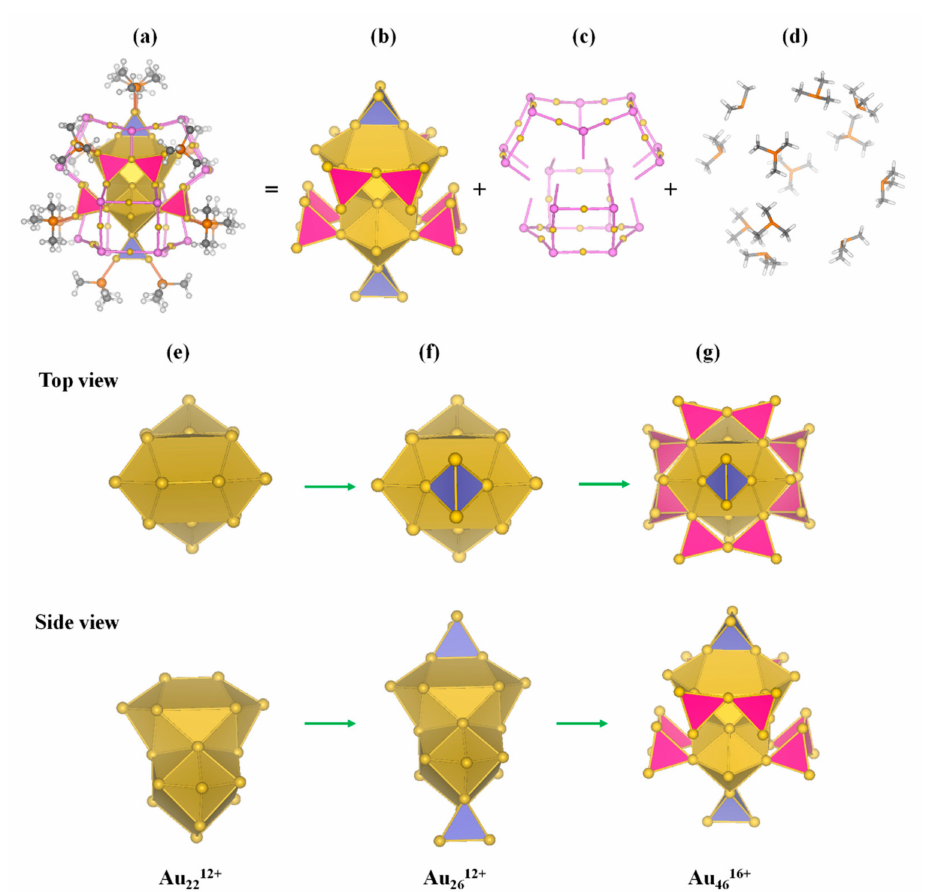
Figure 3. ( a ) Structural model of Au 70 S 20 (PCH 3 ) 12 . The [Au 12 ( µ 3 -S) 10 ] 8 − a nd PCH 3 protecting motifs are given as ball-and-stick models (Au, yellow; P, orange; S, pink; C, gray; H, white). The Au cores are shown as polyhedra. ( b ) Model of Au 4616 + core, ( c ) Two [Au 12 ( µ 3 -S) 10 ] 8 − staple motifs, ( d ) Model of twelve PCH 3 protecting motif, ( e ) Au 2212 + superatomic molecule, ( f ) Au 2612 + core, ( g ) Au 4616 +